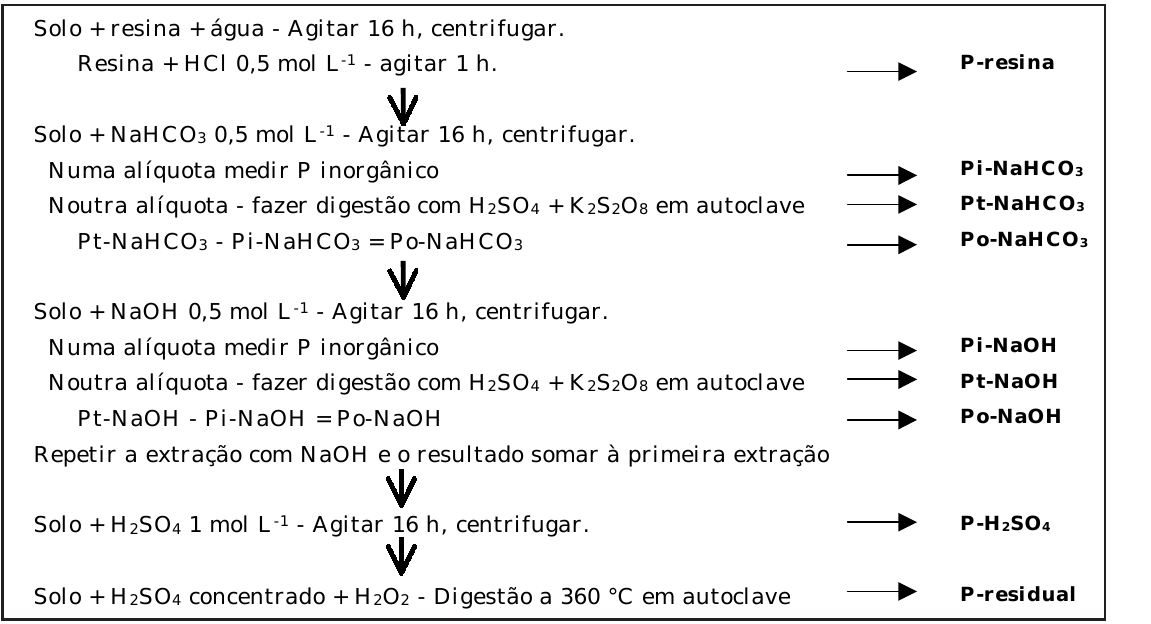
Figura 1. Esquema do fracionamento seqüencial de fósforo (Pi = P inorgânico; Po = P orgânico; Pt = P total), modificado de Hedley et al. (1982).